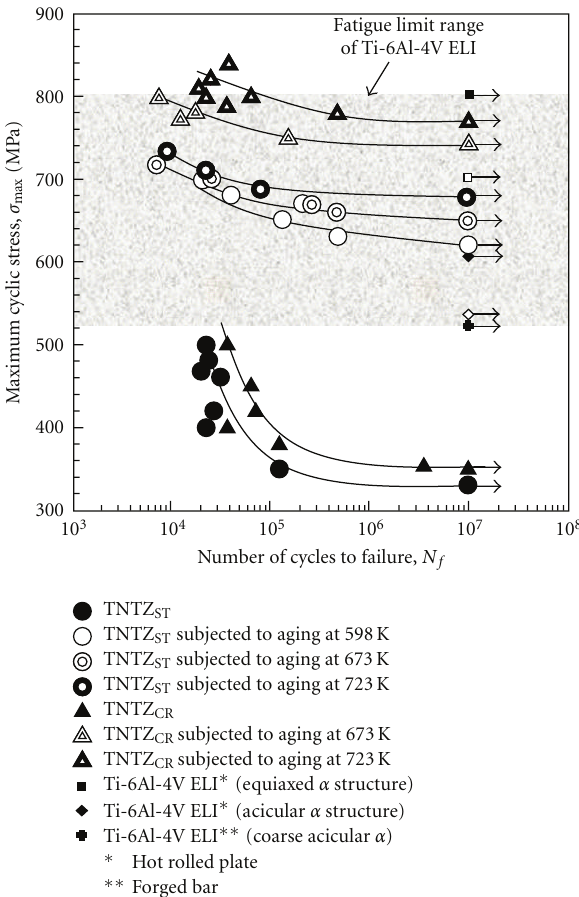
Figure 4: S-N curves of Ti-29Nb-13Ta-4.6Zr (TNTZ) subjected to solution treatment (TNTZ ST ), aging at 598K for 259.2 ks after solution treatment, aging at 673 K for 259.2 ks after solution treatment, aging at 723 K for 259.2 ks after solution treatment, cold rolling (TNTZ CR ), aging at 673 K for 259.2 ks after cold rolling, and aging at 723 K for 259.2 ks after cold rolling along with the fatigue limit range of Ti-6Al-4V